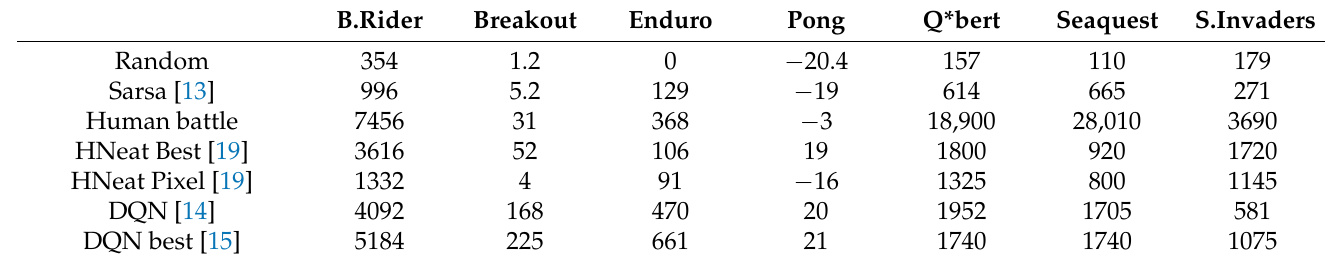
Table 2. The comparison results of applying DQN to Atari game.